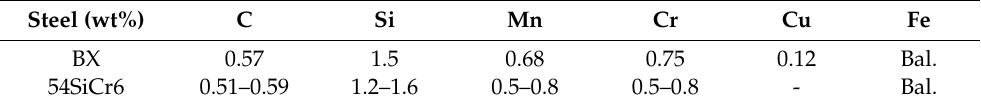
Table 1. The steels’ chemical compositions and standard 54SiCr6 according to ˇCSN EN 10 027-1, wt%.